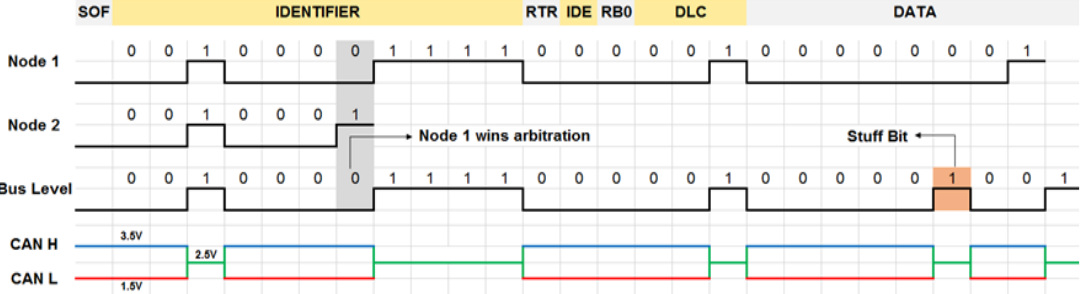
Figure 3. Signalling in CAN; Node 1 wins arbitration without any disruption.